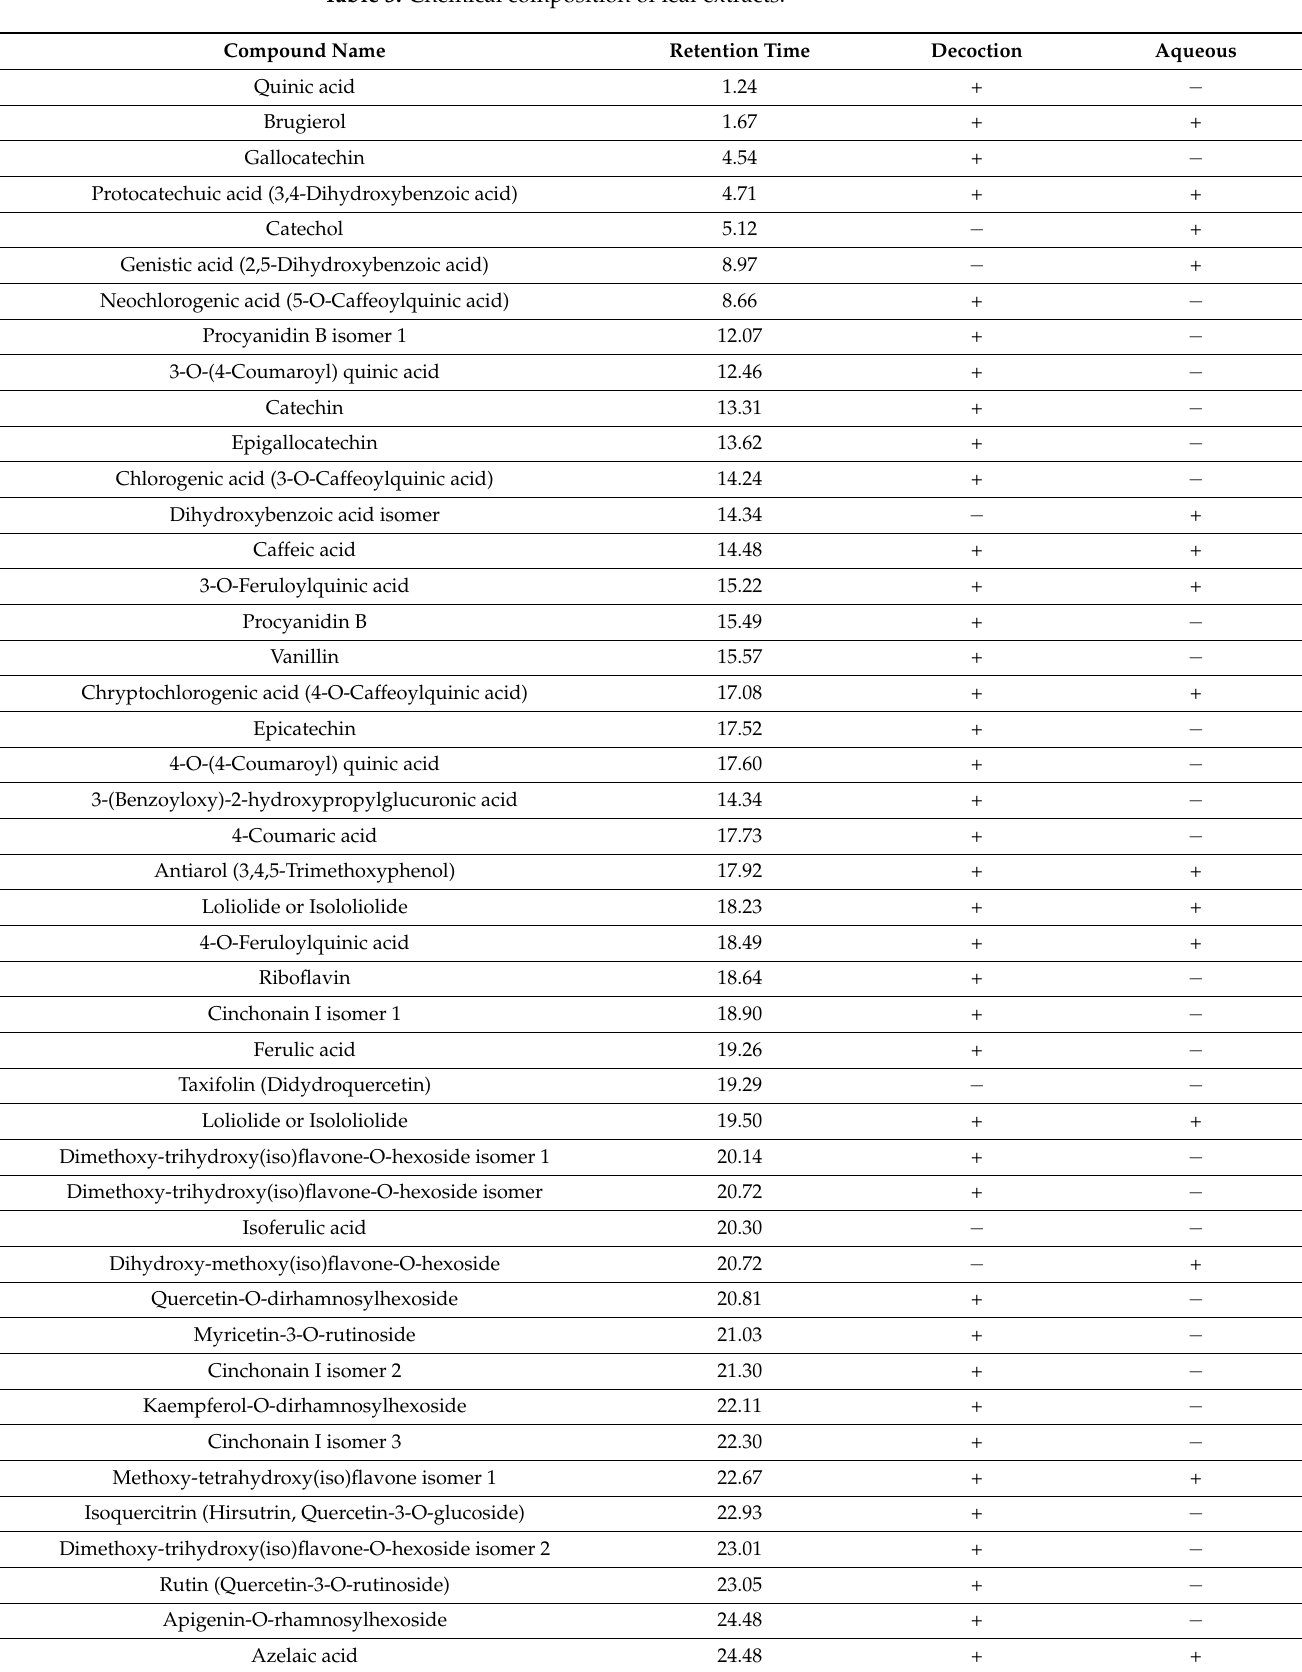
Table 3. Chemical composition of leaf